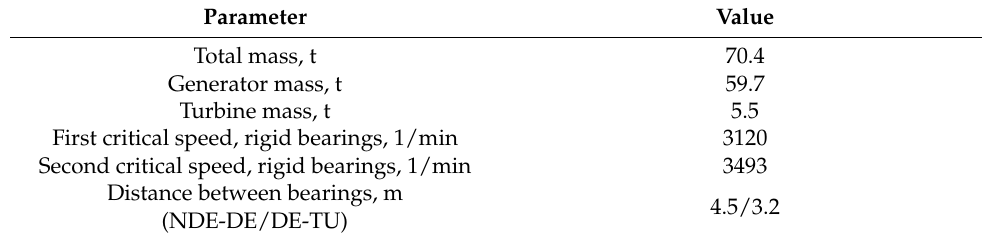
Table 2. Rotor data.